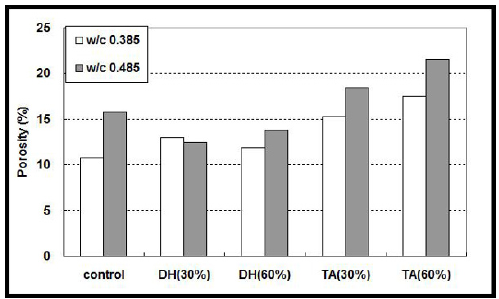
Figure 11. Migration coefficient in PA mortar without